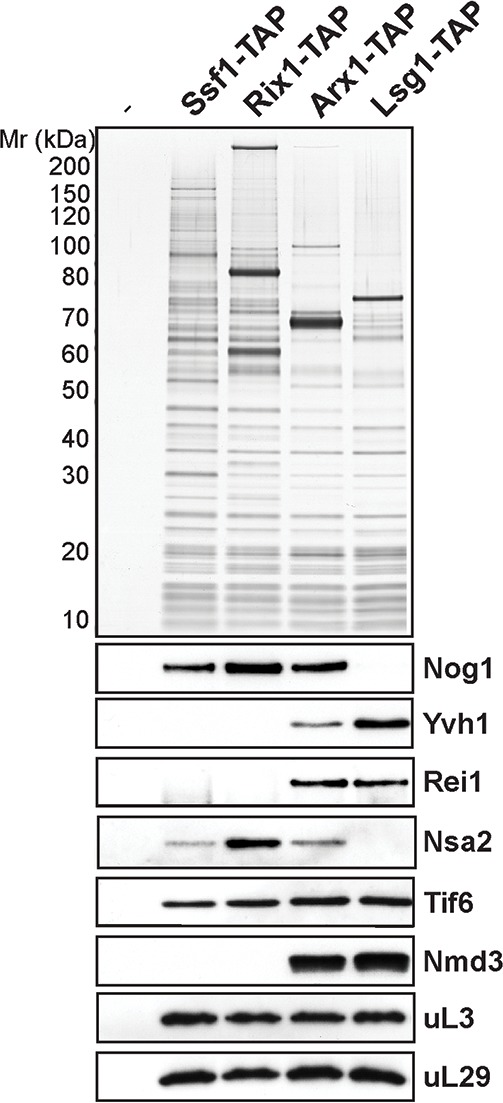
Co-enrichment of assembly factors with a maturing pre-60S subunit.60S pre-ribosomes representing different maturation stages: nucleolar (Ssf1-TAP), nuclear (Rix1-TAP), nuclear and cytoplasmic (Arx1-TAP) and cytoplasmic (Lsg1-TAP) were purified, and selected assembly factors were analyzed by Western blotting.